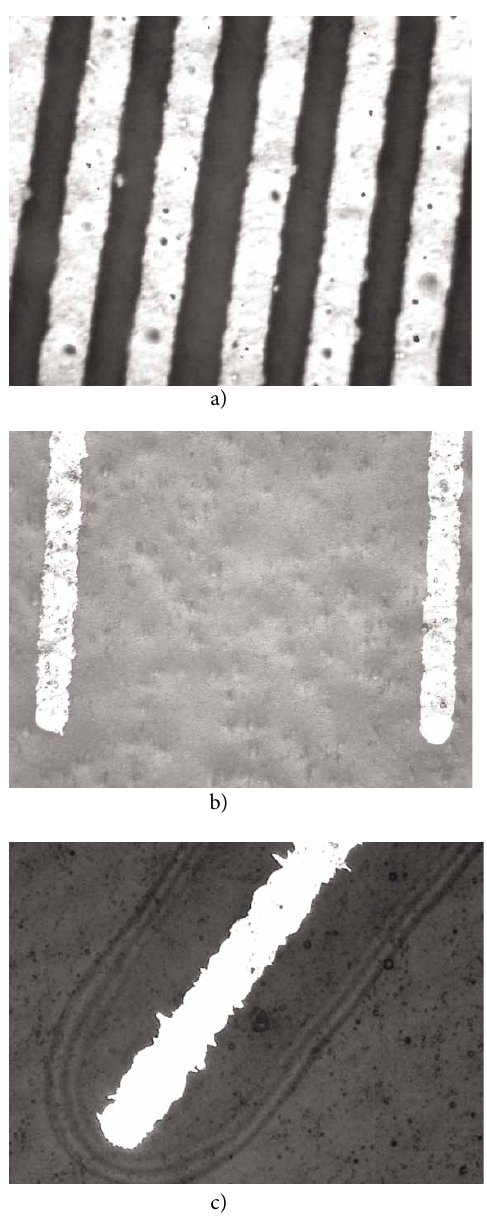
Fig. 5. Further trials (a, b and c) using different laser charge power and positioning means